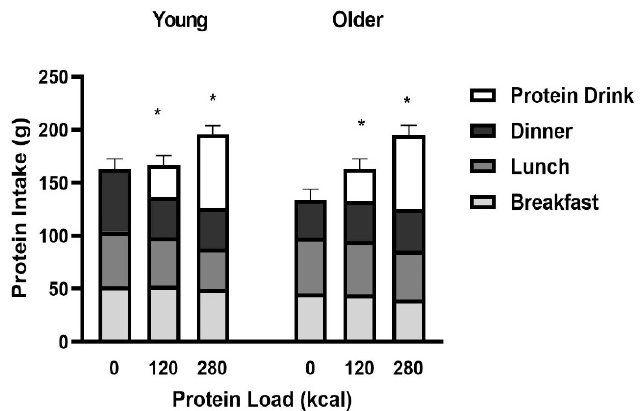
Figure 3. Mean ( ± SEM) protein intake (g) at breakfast (light grey bars), lunch (dark grey bars), and